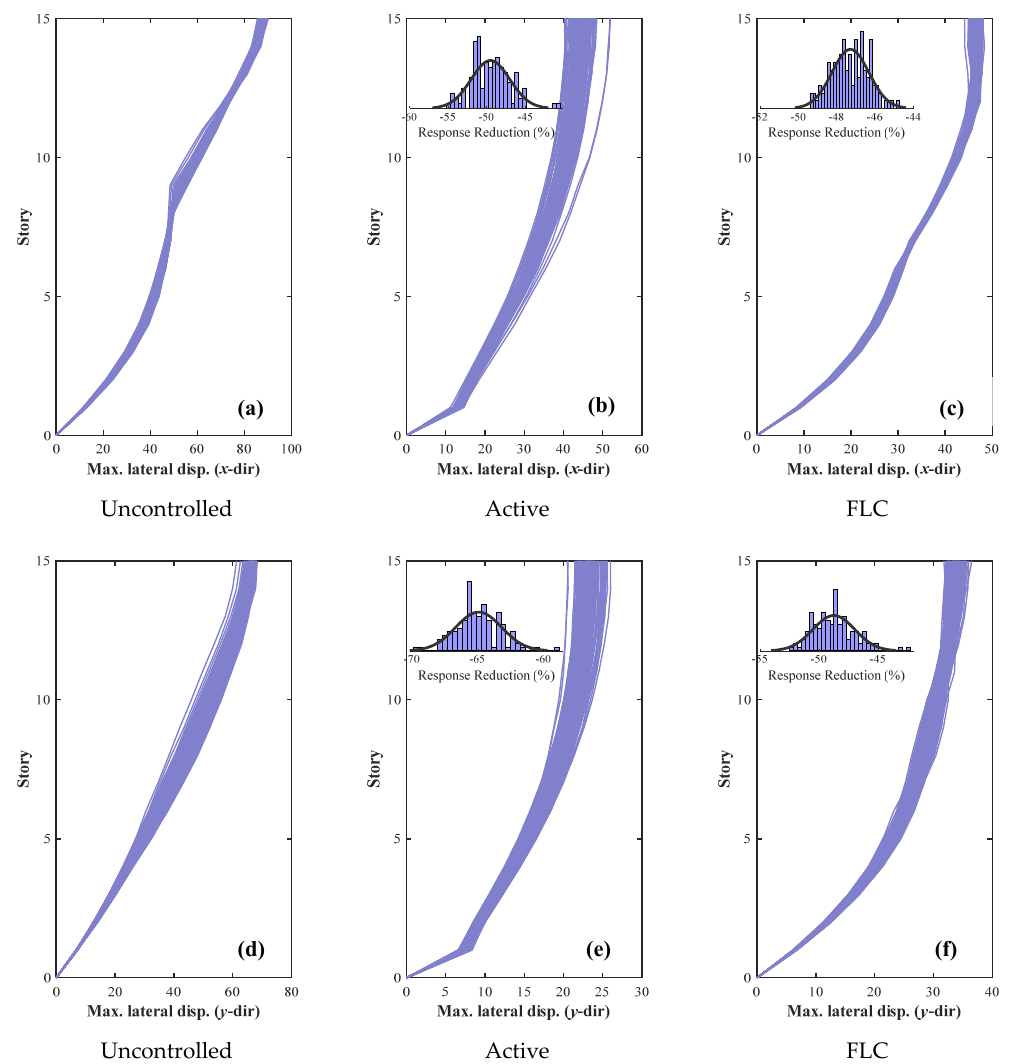
Figure 14. Maximum lateral displacements of the Case-I building considering uncertainties in dynamic properties (soft soil). ( a ) and ( d ): Uncontrolled; ( b ) and ( e ): Active LQR; ( c ) and ( f ): FLC.